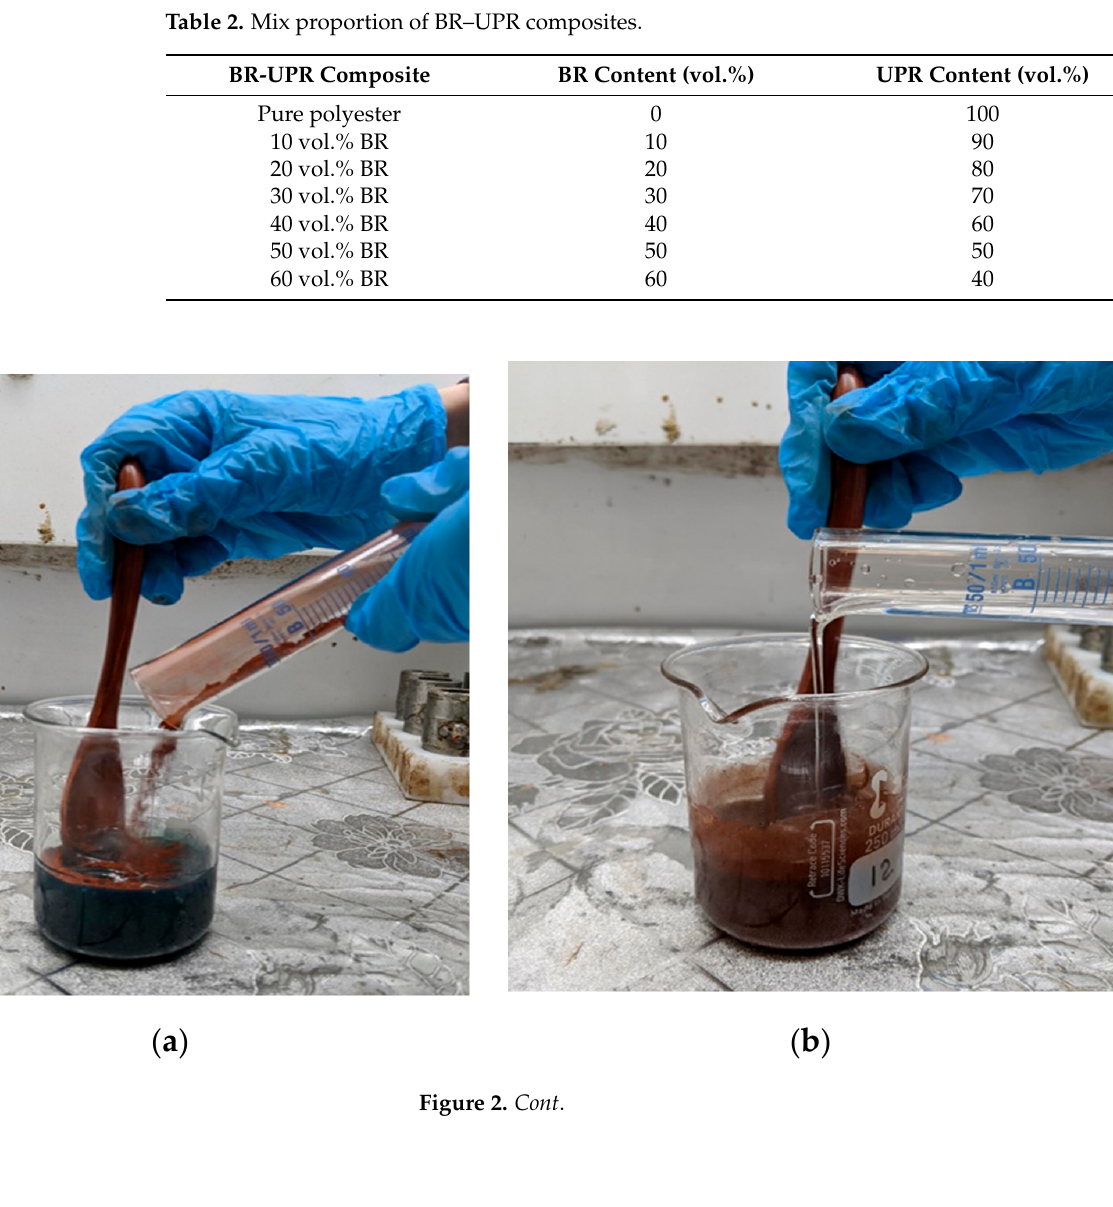
Table 2. Mix proportion of BR–UPR composites.